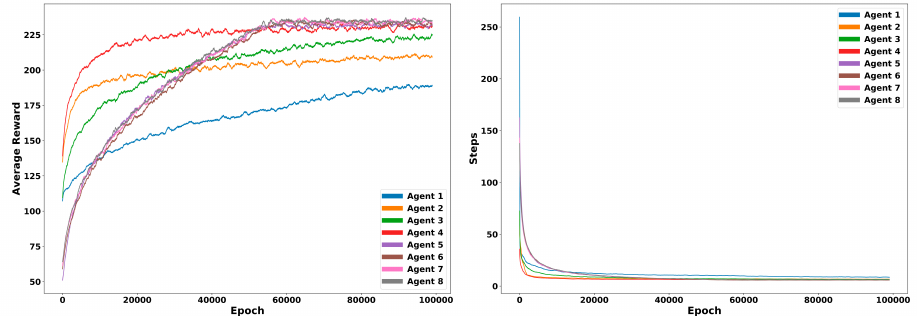
Figure 7. Total reward on episode averaged over 5 different runs for eight different agents ( left ) and the total number of steps averaged over these runs ( right ) using Reward Shaping II. The training of each agent comprised 100,000 episodes and curves are smoothed with a window of 1000 epochs.